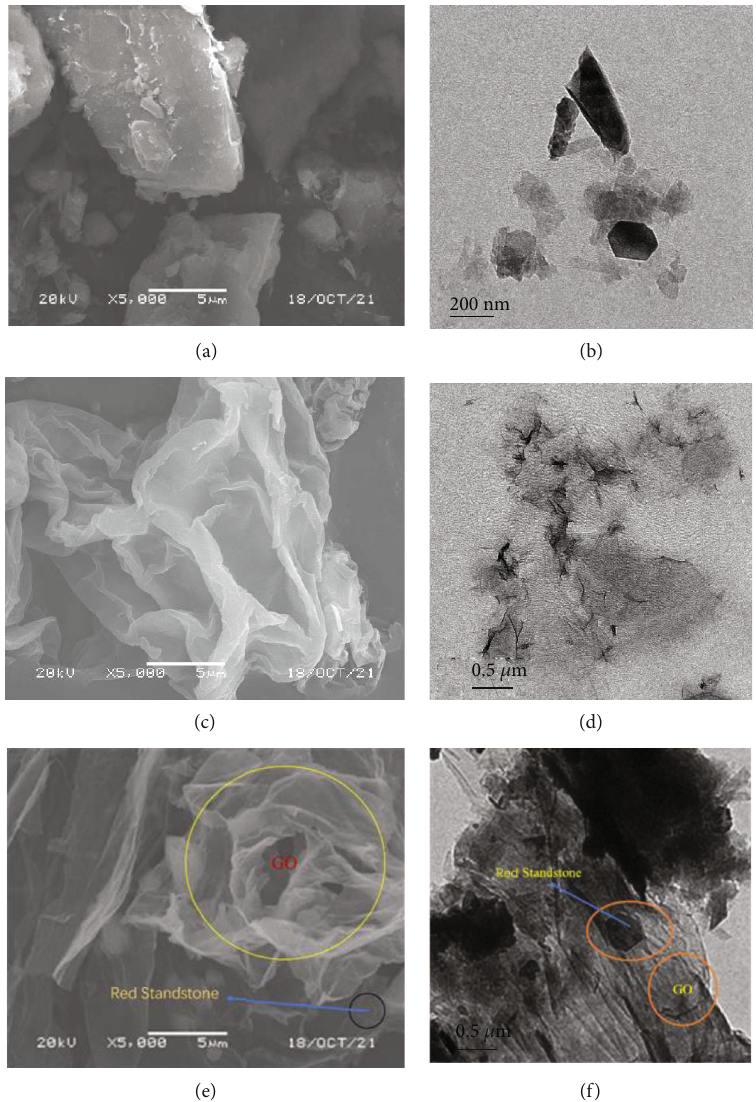
Figure 3: (a) SEM and (b) TEM of red sandstone; (c) SEM and (d) TEM of GO; (e) SEM and (f) TEM of GO/red